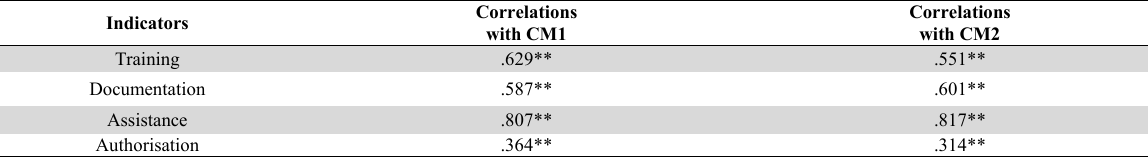
The second-order formative indicators correlations with the two global measures